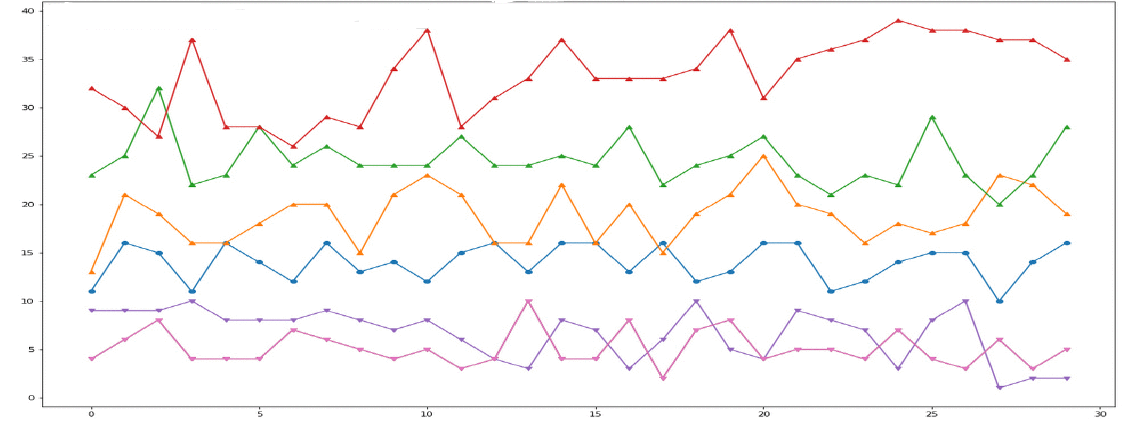
Figure 13. Number of connected components at different data collection points. Blue: Center; Purple: Backward one; Pink: Backward two; Yellow: Forward one; Green: Forward two; Red: Forward